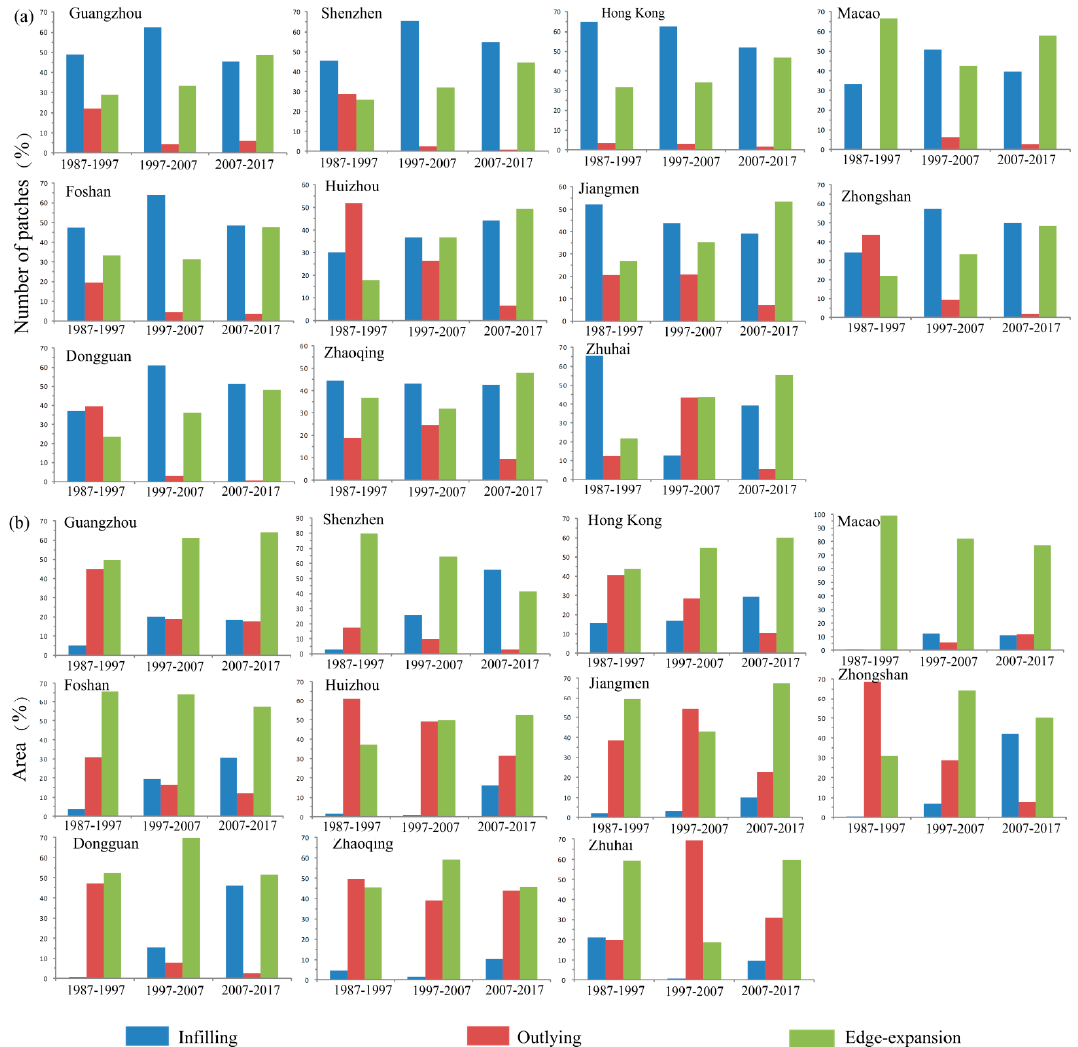
Figure 6. The composition (%) of three urban expansion types for the area (a) and number of patches (b) of newly developed urban patches in 11 cities in the GBA in 1987–2017.